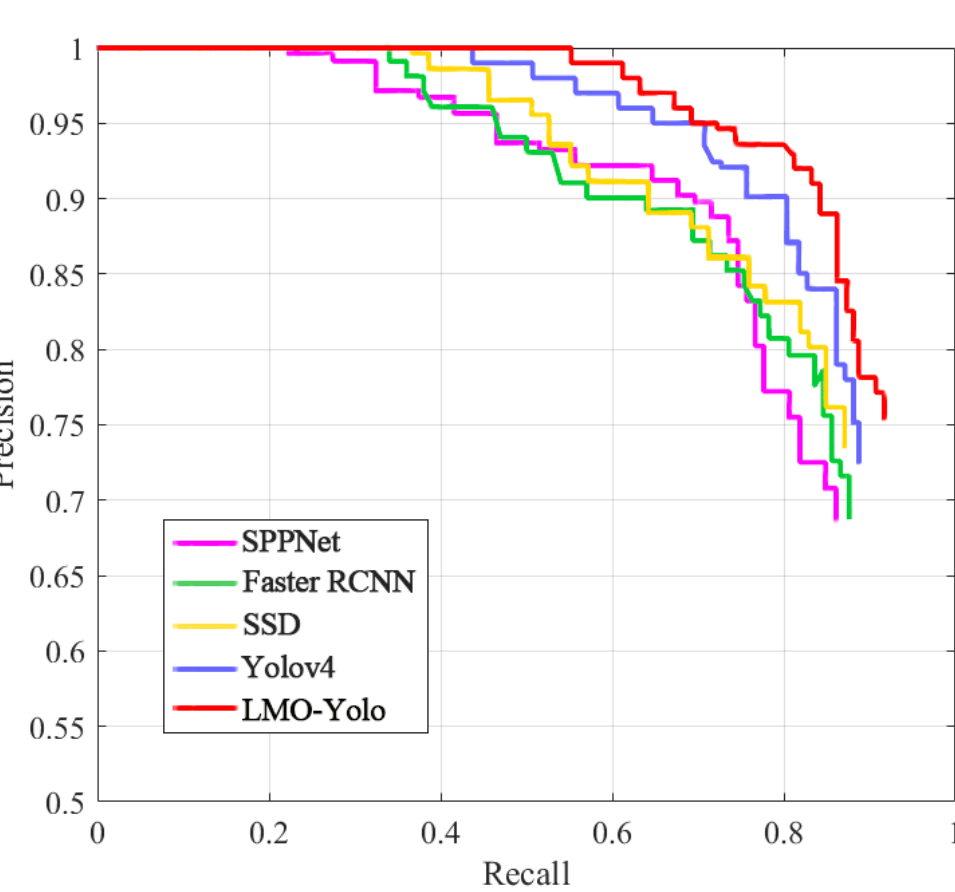
Figure 9. Ship detection precision (%) versus recall (%) for different detection methods. The larger the area under the curve, the better the model